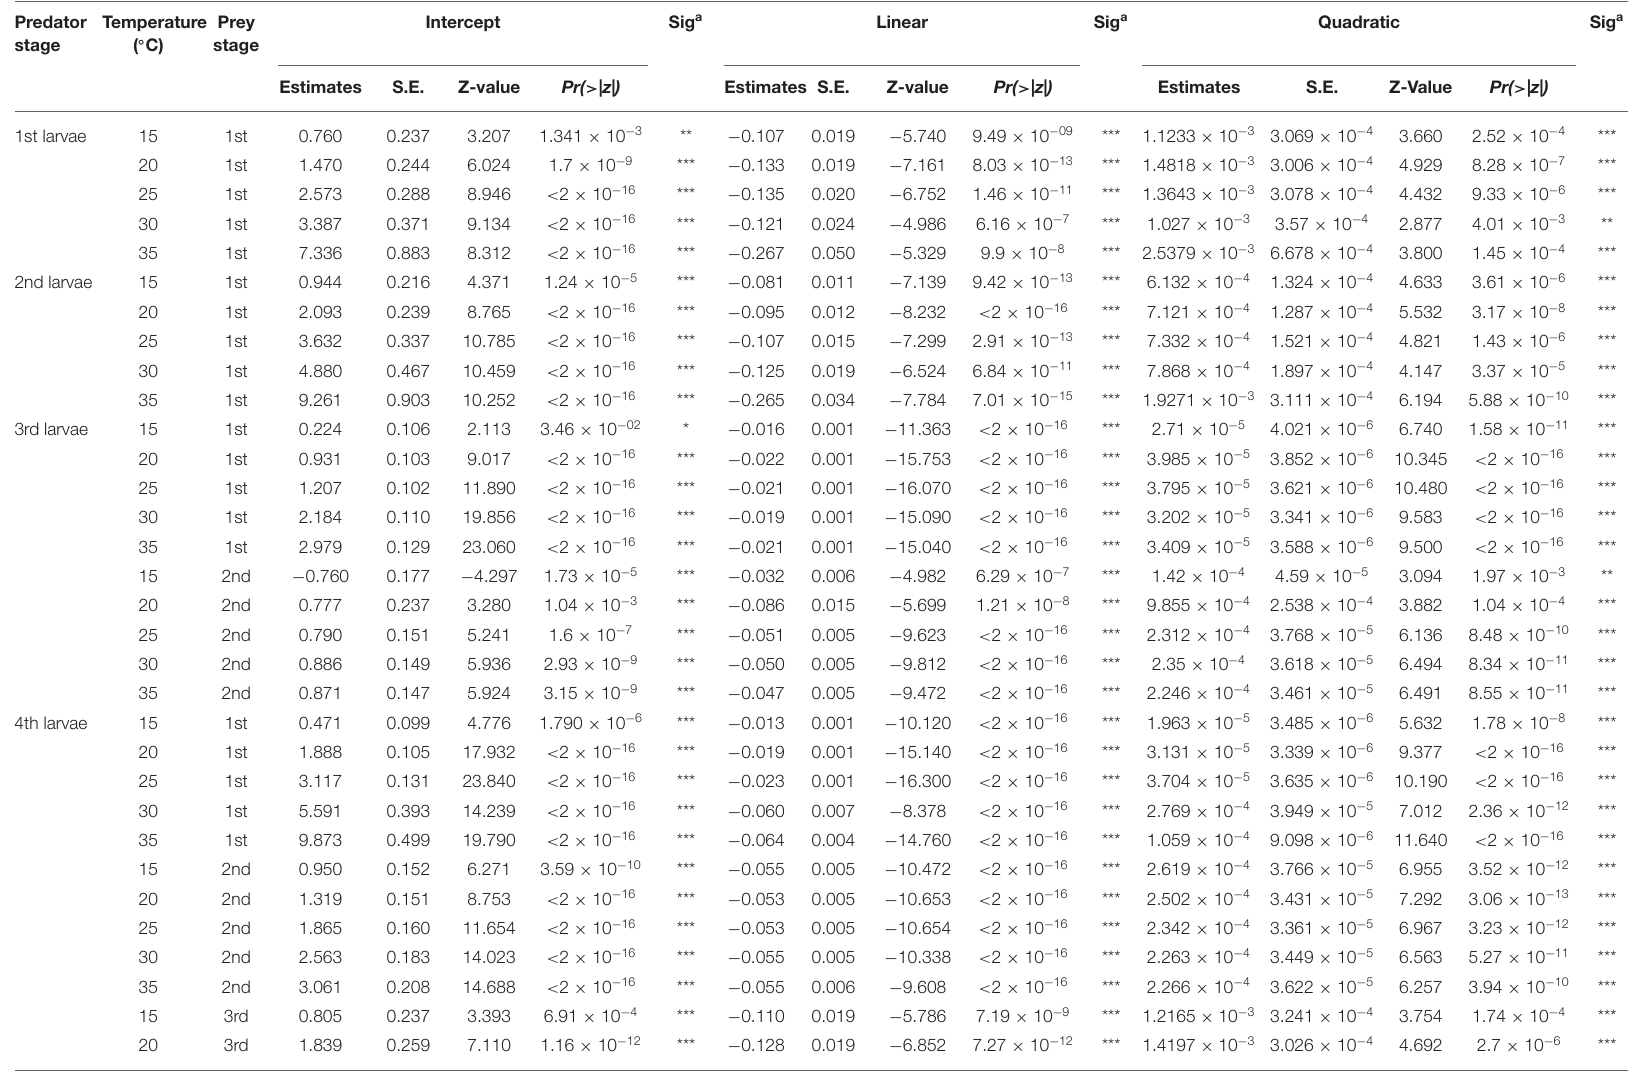
TABLE 1 | Maximum likelihood estimates from logistic regression analyses of the proportion of prey eaten by different stages of Harmonia axyridis preying upon 1st, 2nd, and 3rd instars of prey Spodoptera litura at various temperatures. Predator